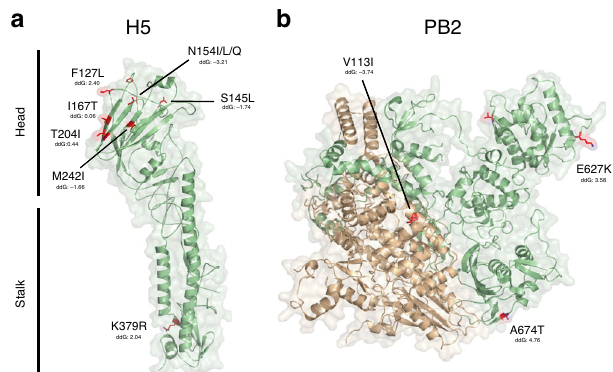
Fig. 5 Functional relevance of HAPMs of H5NX viruses. Protein structure models for the a HA (Hemagglutinin) and the b PB2 (Polymerase complex) of the H5NX viruses. See Fig. 4 legend for further details.